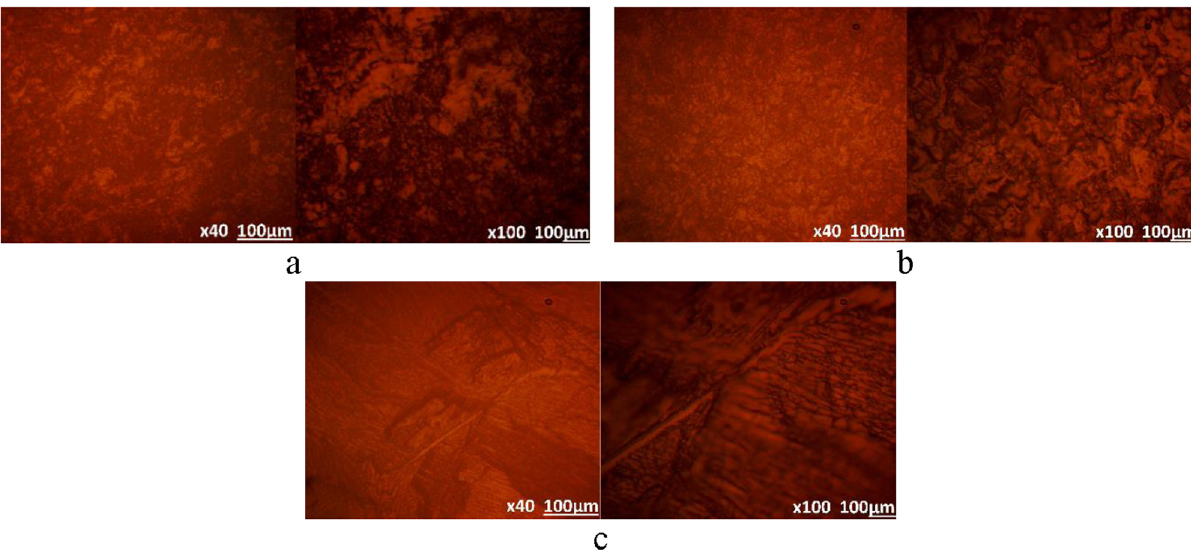
Figure 11: Optical images of ( a ) B265TiN, ( b ) B265TiQ, and ( c ) B265TiA after corrosion test in 6 M H 2 SO 4 + 10% NaCl at 95°C.